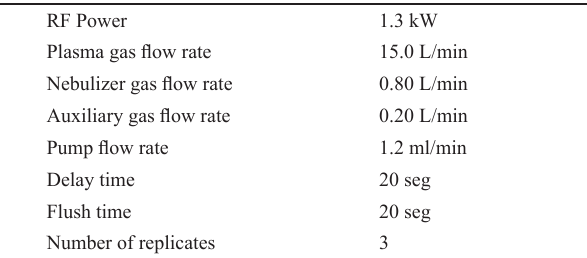
Table 1. Operating conditions of the ICP-OES equipment.